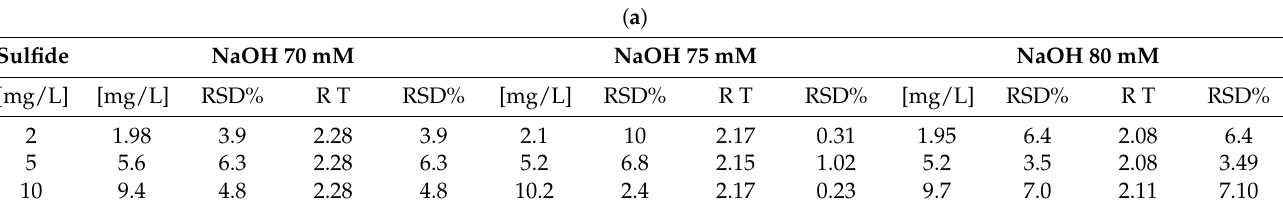
Table 1. Assessment of robustness modifying mobile phase ( a ) and flow rate ( b ). Each measurement was performed on quadruplicate; the mean and the Relative standard deviation (RSD%) have been evaluated for both concentration (mg/L) and retention time (RT),